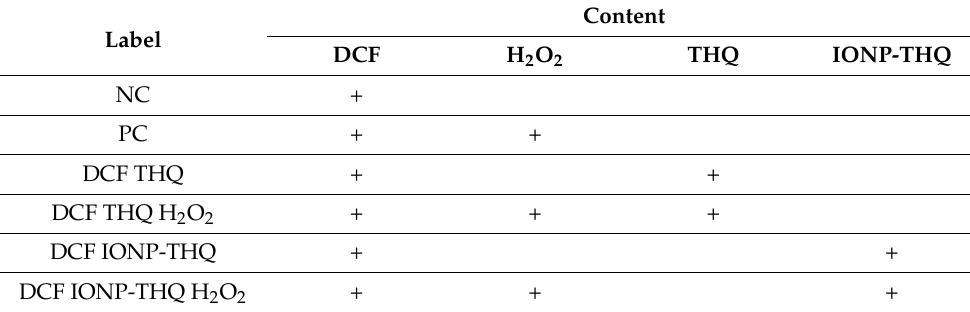
Table 2. Content and labels of the samples for ROS measurement. Label